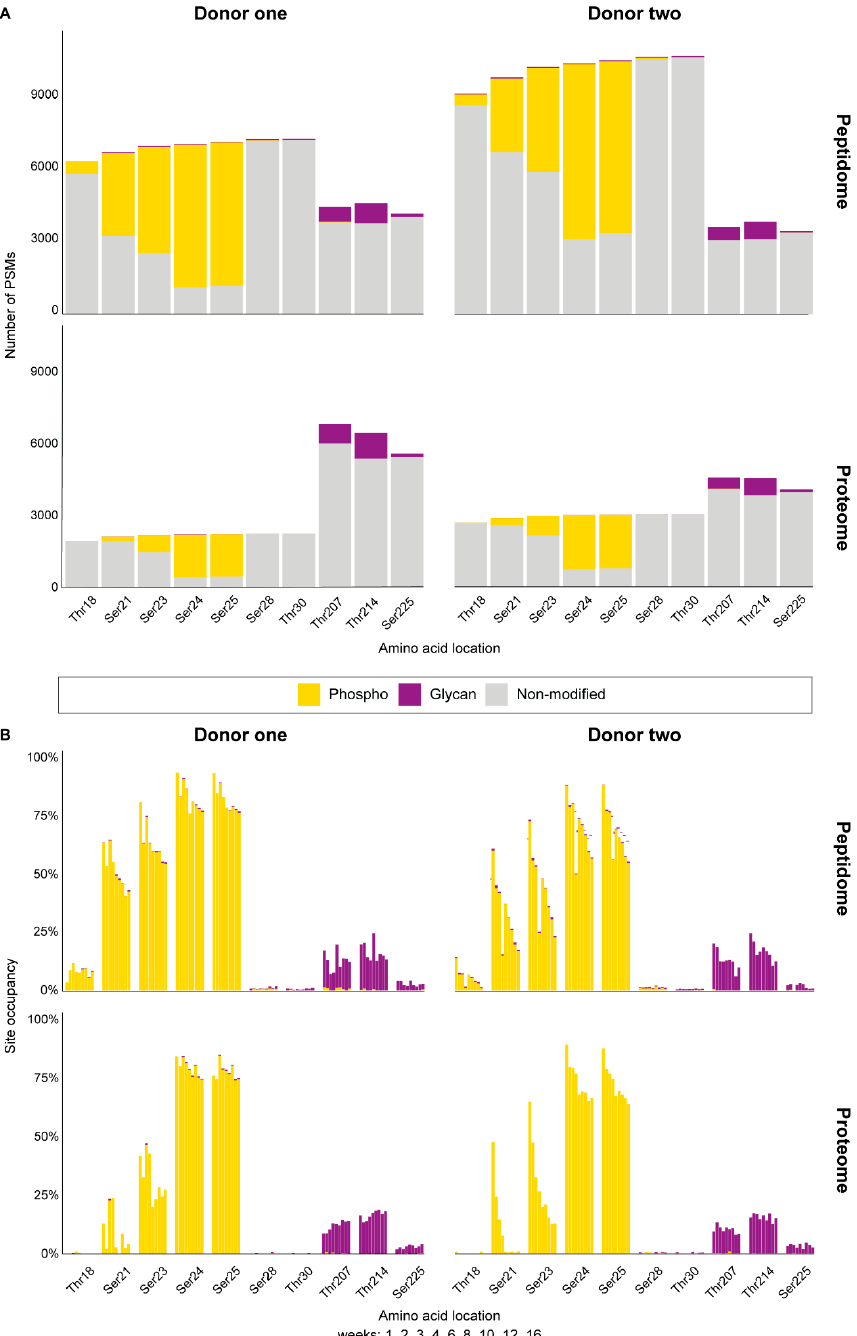
Figure 4. Semi-quantitative analysis of phosphorylated and glycosylated amino acids detected in β -casein across lactation. ( A ) Total number of detections of Thr18, Ser21, Ser23, Ser24, Ser25, Ser28, Thr30, Thr208, Thr214, and Ser225 for each donor in either the peptidome and proteome, colored for the presence of phosphorylation (yellow), glycosylation (purple), or without modifications (grey). ( B ) Percentage of modified amino acids amongst the total number of detections, separately displayed for lactation weeks 1, 2, 3, 4, 6, 8, 10, 12, and 16. While the observed PTMs are donor-specific, overall, the peptidome data displays a greater relative abundance of phosphorylated and glycosylated sites than the proteome data, and highly similar changes can be seen across lactation for both donors. Whereas all phosphorylation sites are near the N-terminus, the O- glycosylation sites are all at the C-terminus of β -casein.